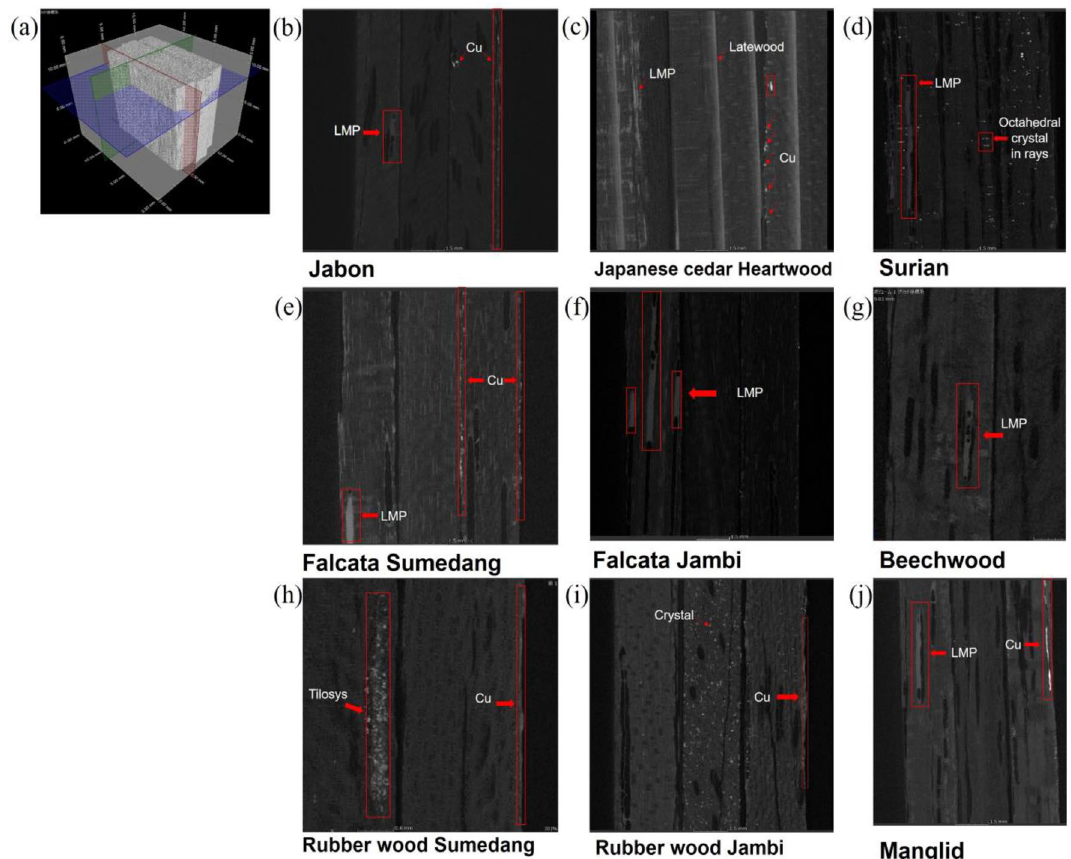
Figure 5. A 3D X-ray observation of the distribution of LMP and Cu. ( a ) A 3D image stack of the treated- veneer by LMP and copper naphthenate, and the untreated veneer; softwood and hardwood 2D representative images of a radial section were obtained from the green cut section of the 3D image, ( b ) Jabon wood from Sumedang city, ( c ) Japanese cedar heartwood veneer, ( d ) Surian wood, ( e ) Falcata wood from Sumedang city, ( f ) Falcata wood from Jambi city, ( g ) Beechwood, ( h ) Rubber wood from Sumedang city, ( i ) Rubber wood from Jambi city, and ( j ) Manglid